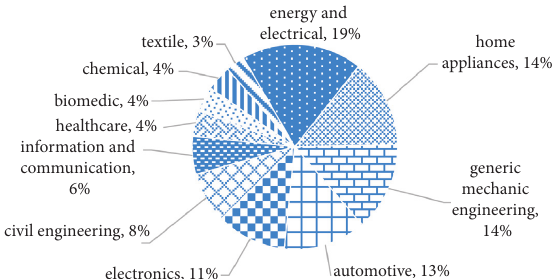
Figure 2: Use of TRIZ worldwide (data source: Spreafico and Russon